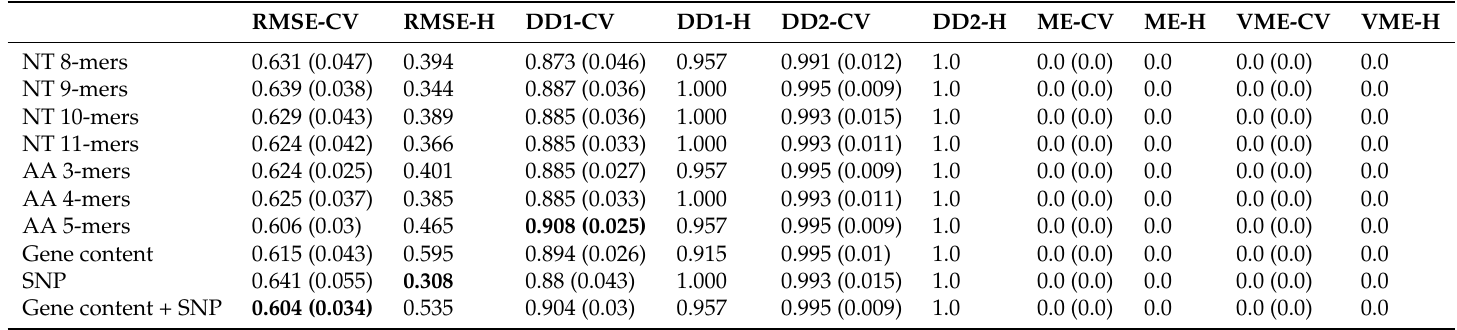
Table A16. C. jejuni